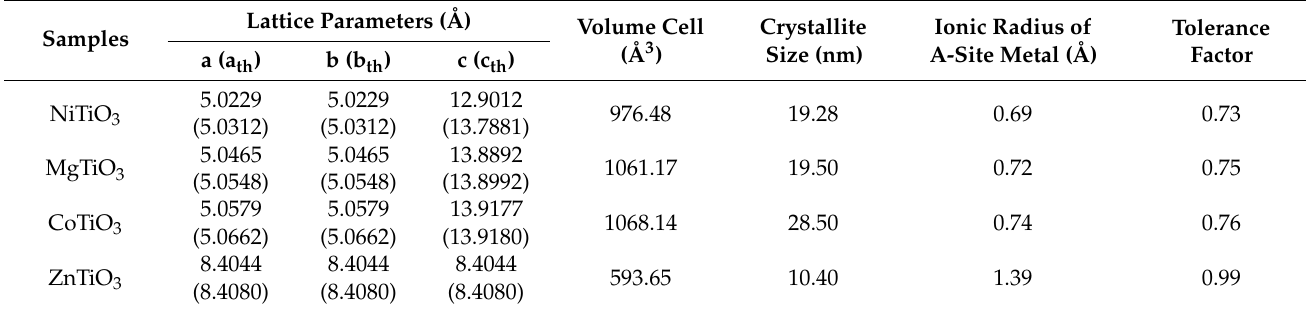
Table 1. Lattice parameters, volume cell, crystallite size, ionic radius, and tolerance factor of metal titanate nanorods ATiO 3 (A = Mg, Co, Ni, Zn).